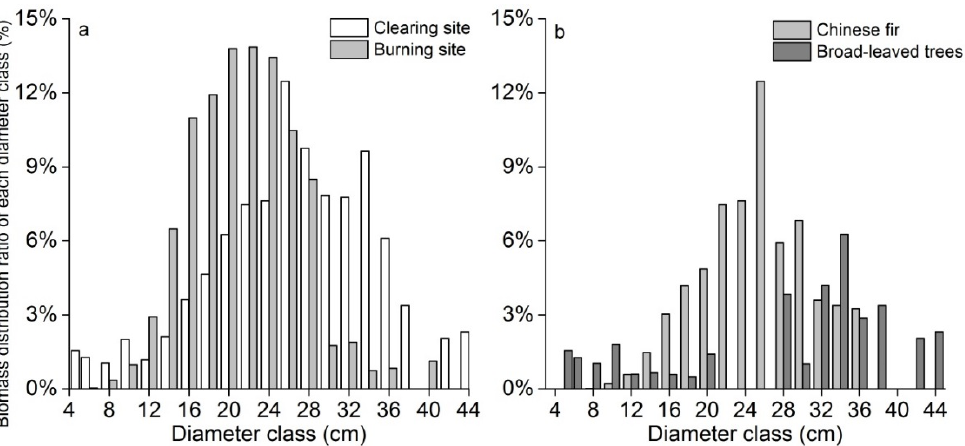
Figure 6. The biomass distribution ratio of each diameter class in the controlled burning and brush clearing sites ( a ) and the biomass distribution ratio of each diameter class of Chinese fir and broadleaved trees in the brush clearing site ( b